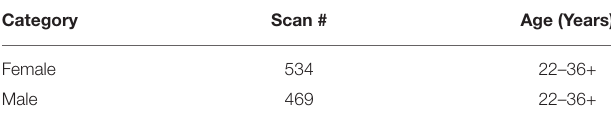
TABLE 2 | The main demographic information of 1,003